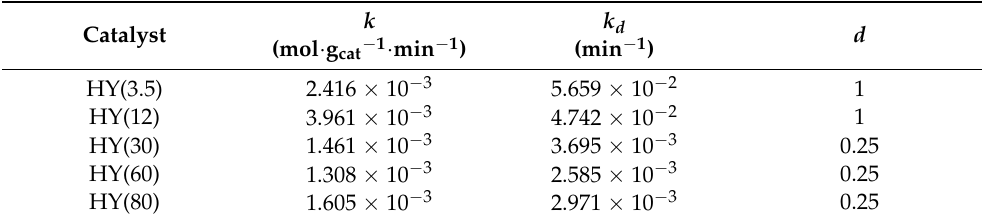
Table 3. Reaction rate constants ( k ), deactivation rate constants ( k d ) and deactivation orders ( d ) for the glycerol dehydration over HY zeolites.